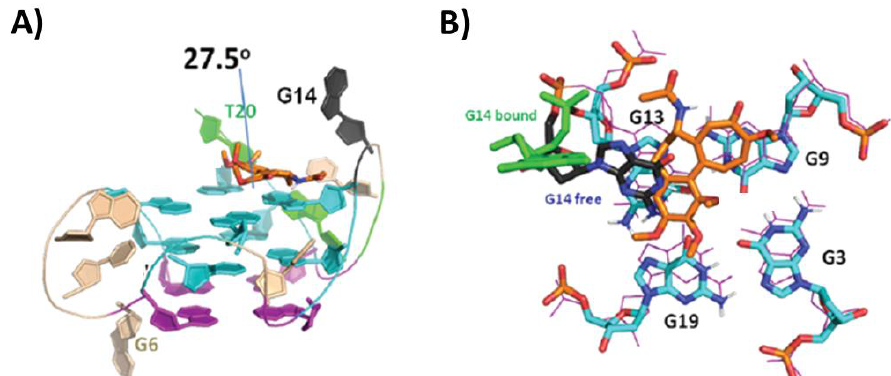
Figure 12. ( A ) NMR structure of the complex between the unimolecular parallel G-quadruplex RET of sequence d(GGGGCGGGGCGGGGCGGGGT) and colchicine. 3′ - and 5′ -end of the G-quadruplex are at the top and bottom, respectively. Details of the ligand binding are highlighted in ( B ). Adapted with permission from ref. [94], Copyright 2020 The Royal Society of Chemistry.